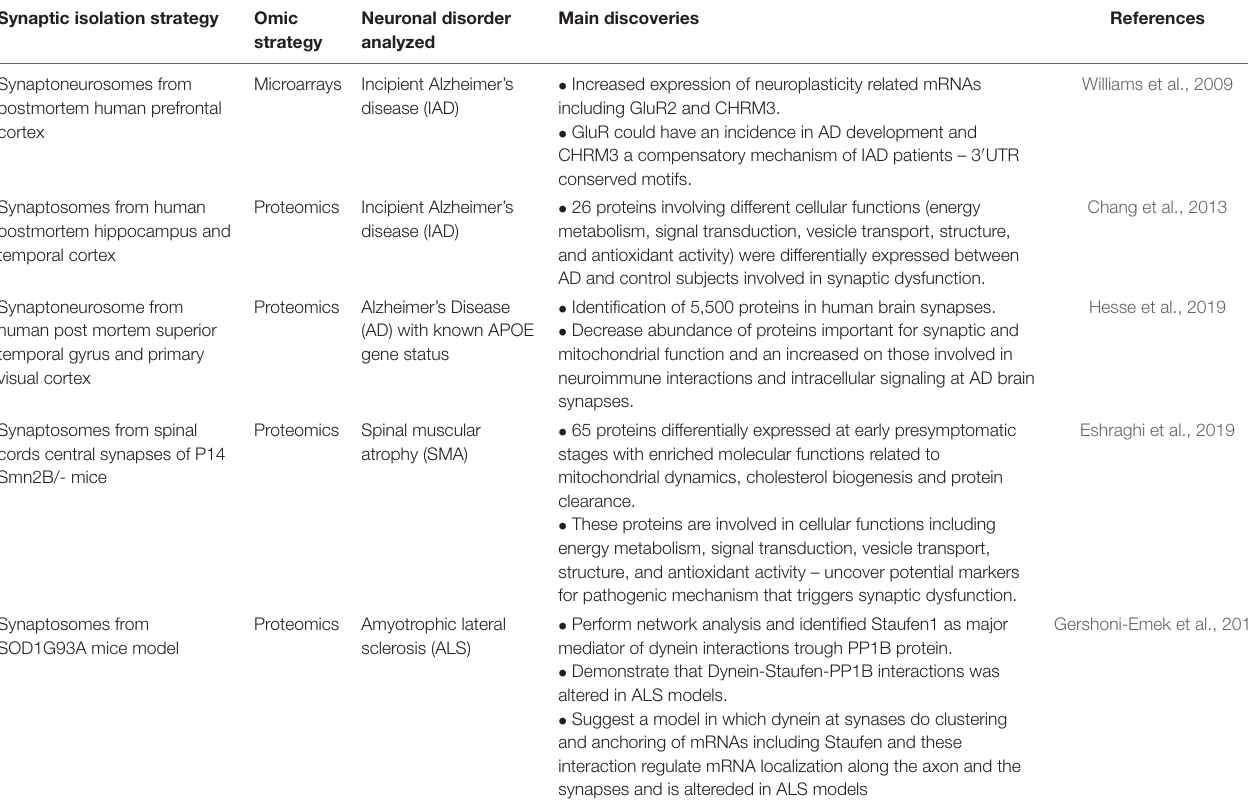
TABLE 4 | Summary of synaptic omic approaches for the study of neurodegenerative